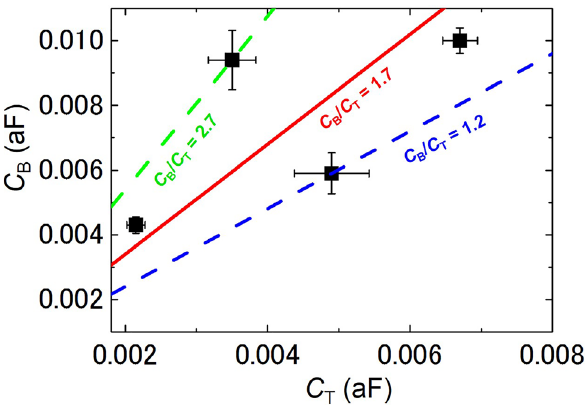
Figure 4. Plots of C B vs. C T of four devices, indicating simple current oscillation characteristics that originated from a single dot. C B of four devices was evaluated by the period of the current peak line. However, C T of four devices was evaluated by C B and the slope of the current peak line. C B includes the fluctuations that were derived from reading errors of the period of the current peak line, which are shown by the vertical error bars. The horizontal error bars represent the fluctuations of C T that originated from the fluctuations of C B . There was a positive correlation between C B and C T . The slope of the dotted line corresponds to the evaluated C B / C T ~ 1.2 (blue) and ~ 2.7 (green). Although the data approximately follow the relation without considering the shape effect of the nanodot system (red line), clear discrepancy from the red line was